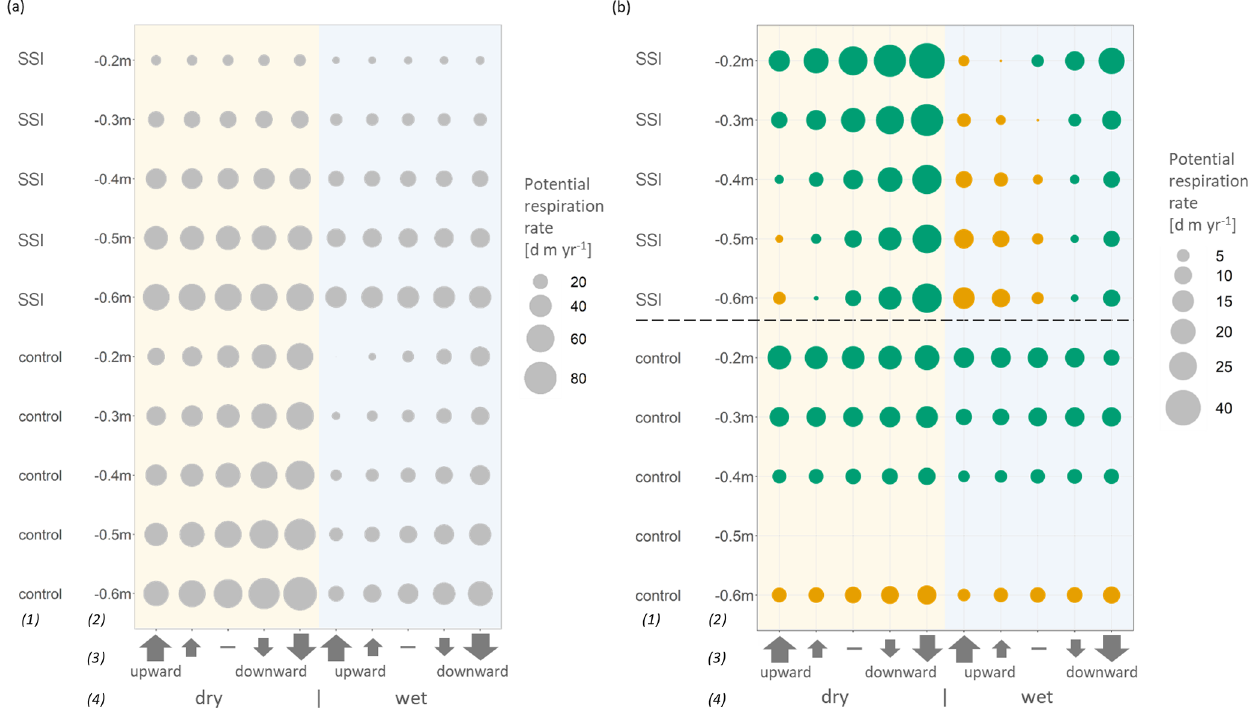
Figure 8. (a) Dot graph of calculated potential respiration rate over the complete width of the model domain. Model runs are distinguished by (1) application of SSI, (2) ditchwater level from surface, (3) hydrological regime (1mmd − 1 upward to downward flow across the bottom boundary) and (4) meteorology (2018 for dry, 2012 for wet). (b) Effects of SSI (above) and ditchwater level (below) on respiration rate. Green dots represent a decrease in respiration rate. Effects of SSI were determined by comparing similar model runs with and without SSI. Effects of ditchwater level were determined by comparing each scenario in which the water level is 0.5m below surface, with the other scenarios in the same category on the x axis.